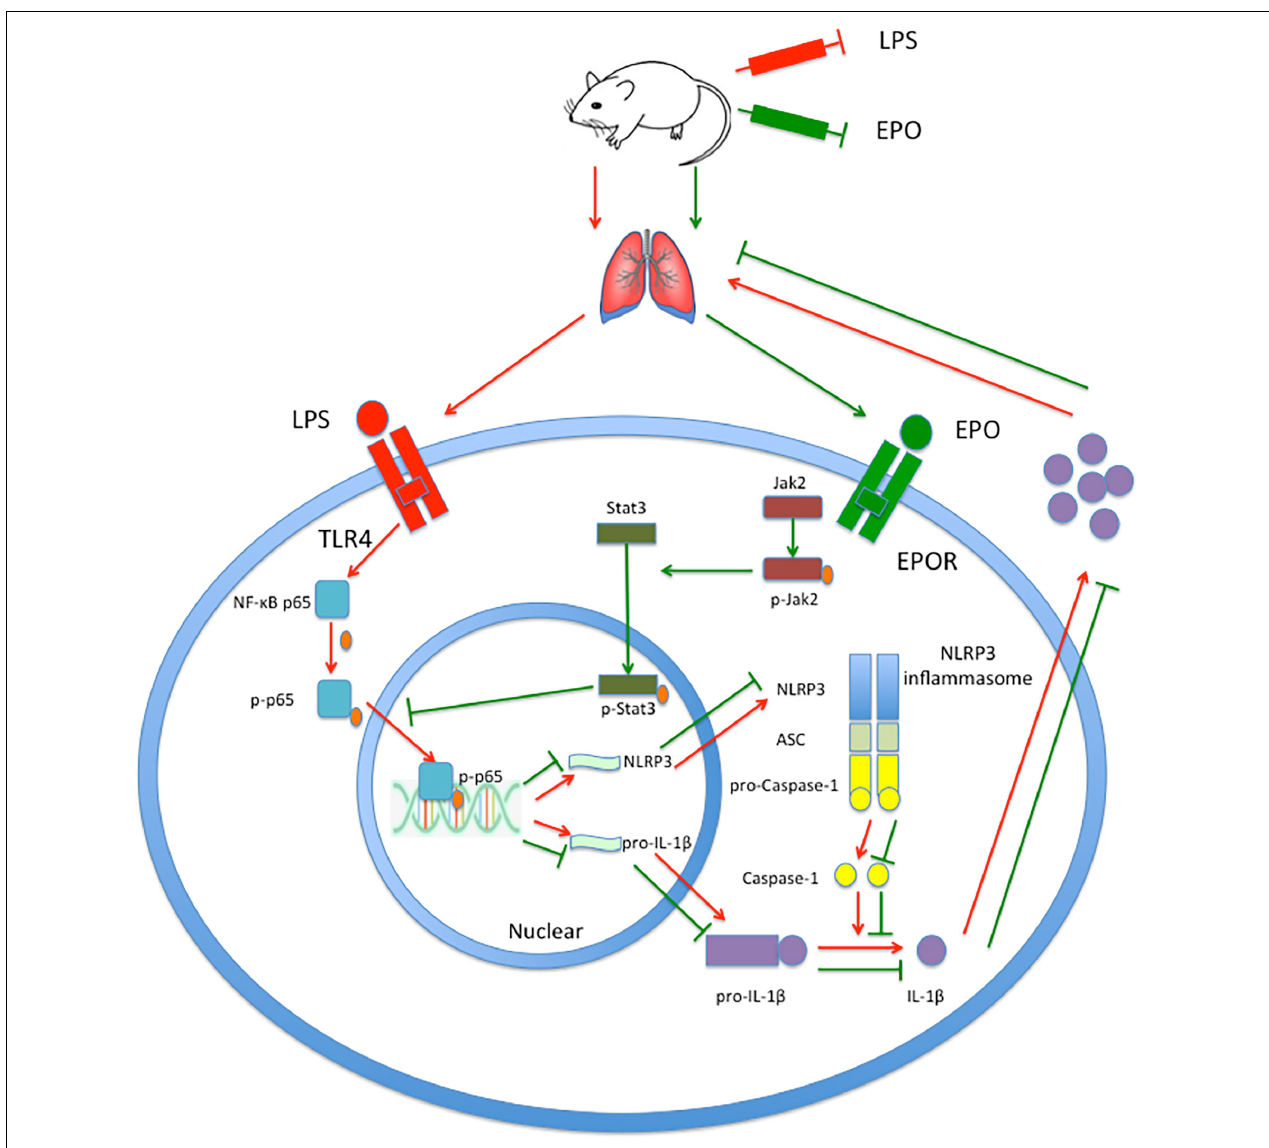
FIGURE 10 | EPO attenuated LPS-induced acute lung injury by suppressing the NLRP3 inflammasome via the EPOR/JAK2/STAT3/NF- κ B pathway in mice. EPO binds to EPOR, further phosphorylates JAK2 to p-JAK2, and controls the kinase activity of JAK2 to phosphorylate STAT3 to p-STAT3. Subsequently, p-STAT3 inhibits the phosphorylation of NF- κ B p65 and the transcriptional activity of NF- κ B p-p65 to attenuate the transcription and expression of NLRP3 and pro-IL-1 β , which consequently leads to a decrease in mature IL-1 β levels and the mitigation of lung